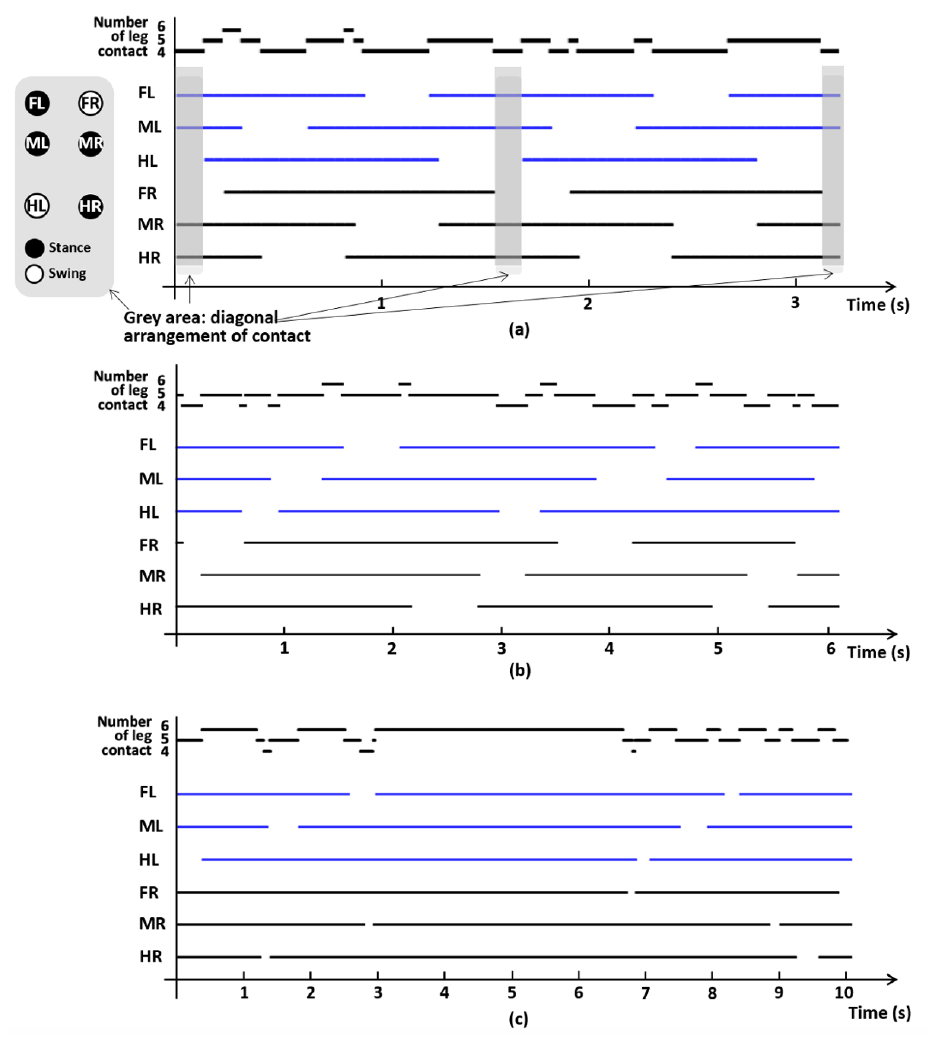
Figure 8. Example gait data from one of the three grasshoppers, representing stance or swing phase for each of six legs, at ( a ) 1.1, ( b ) 0.67, and ( c ) 0.21 cm/s. The solid line indicates stance phase and no line indicates swing phase. Each of the graphs represents fast, medium, and slow walking speeds. The grey areas in Figure 8a indicate that overall legs on the ground are diagonally arranged, while this diagonal arrangement of contact cannot be found in other speed settings. FL: foreleg left-side, ML: midleg left-side, HL: hindleg left-side, FR: foreleg right-side, MR: midleg right-side, HR: hindleg right-side.